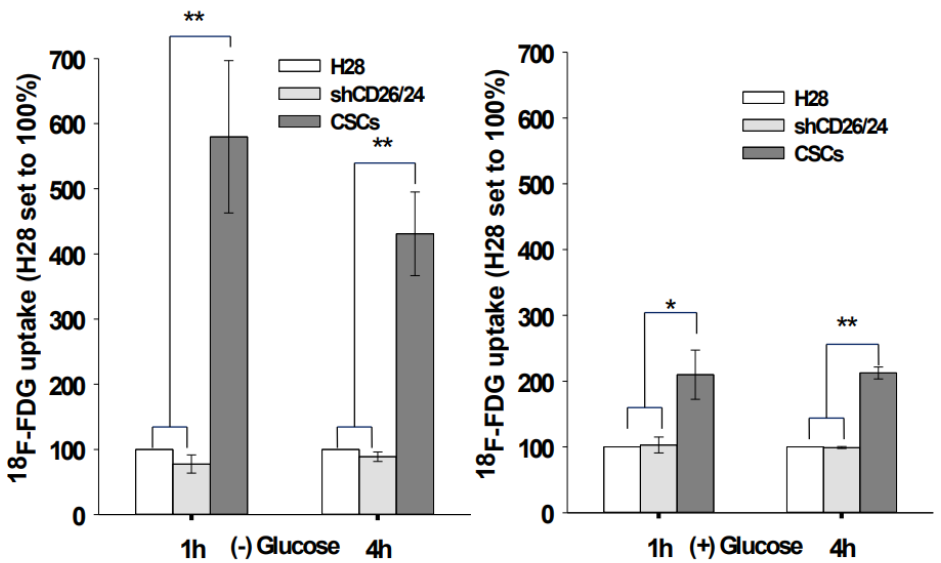
Figure 4. Cell growth assay on MMs of H28. Mean ± SD ( n = 3), p < 0.01 (**).